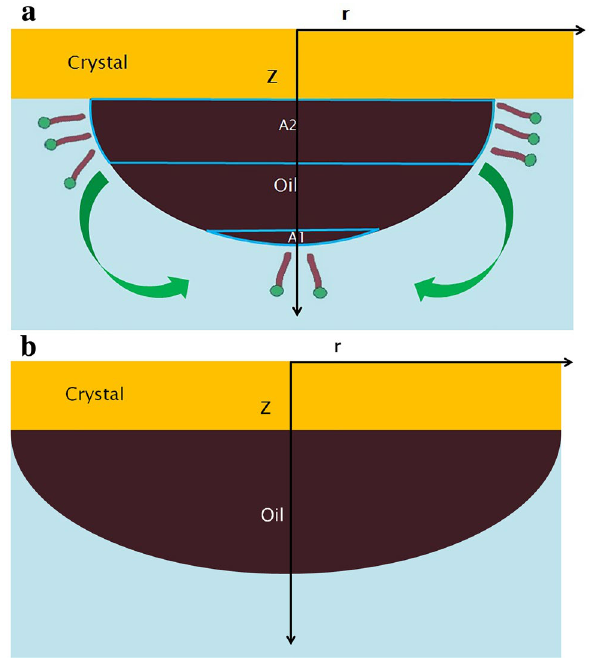
A Schematic diagram of different forces working along